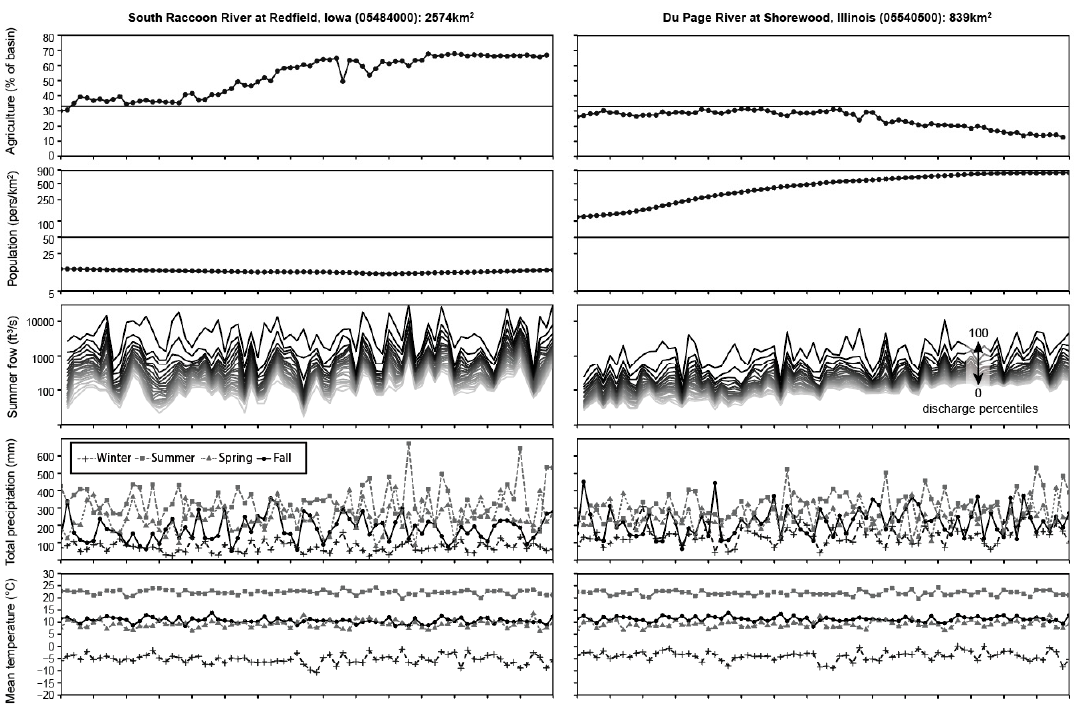
Figure 3. Examples of one agricultural and one urban site: ( Left ) South Raccoon River at Redfield, Iowa (agricultural); ( Right ) Du Page River at Shorewood, Illinois (urban). Rows indicate time series of five basin-averaged predictors (1940–2015). Row 1: Agricultural land cover (% of basin; black circles); the horizontal black line shown at 33% is the cut off point for selecting agricultural basins. Row 2: Population density (persons/km 2 ); the horizontal line shown at 50 persons/km 2 is the cutoff point for selecting urban basins. Row 3: Streamflow quantiles ranging from Q 0 to Q 1 , with a step of 0.05, on a logarithmic scale. Row 4: Total seasonal precipitation (mm). Row 5: Mean seasonal temperature (°C). In Rows 4 and 5, each season is shown with a different symbol: winter (pluses), summer (squares), spring (triangles), and fall (circles). See Figure S1 for plots of streamflow and predictors at all 290 sites.